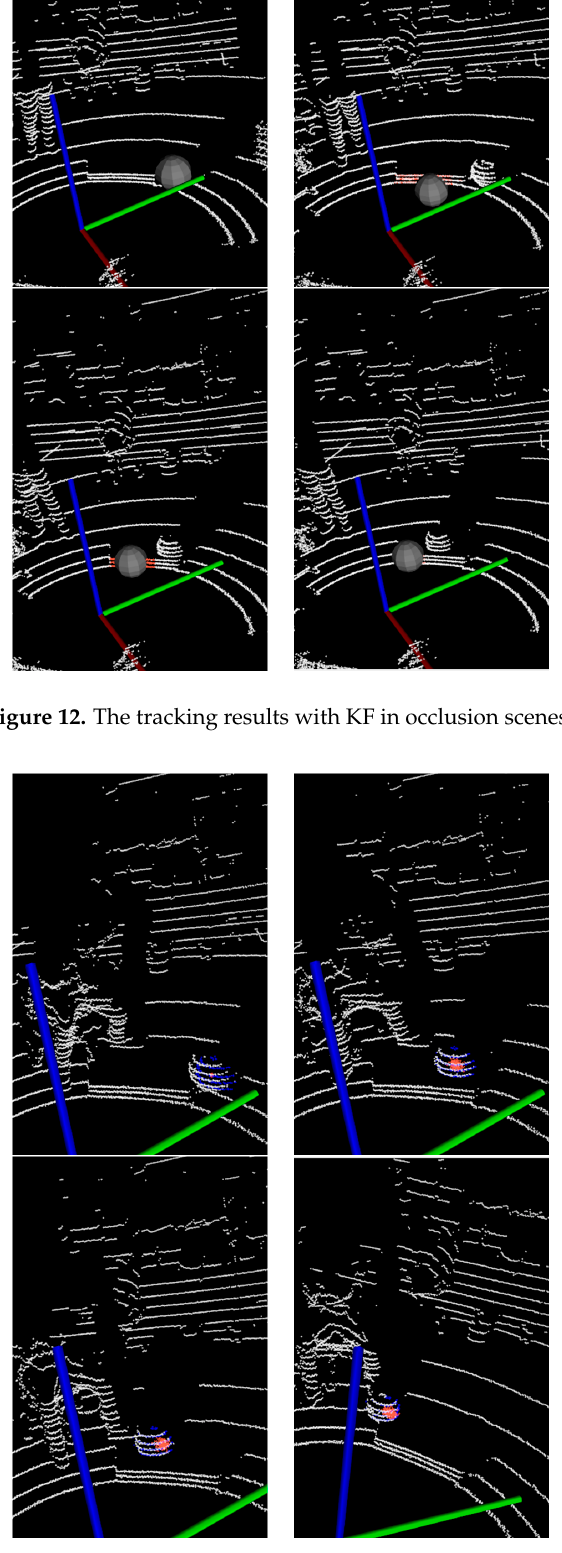
Figure 13. The tracking results with adaptive PF in occlusion scenes.